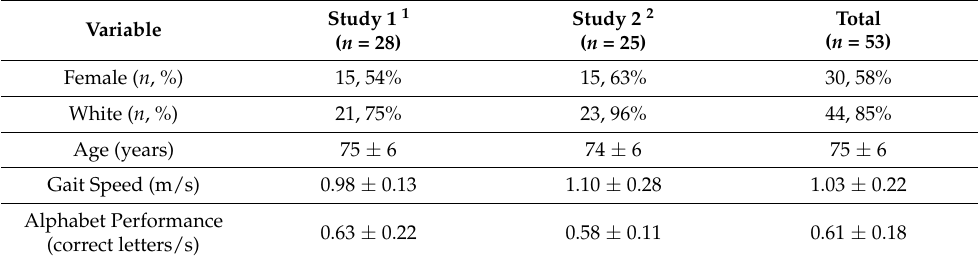
Table 1. Summary of demographic information and descriptive characteristics for subjects by study and